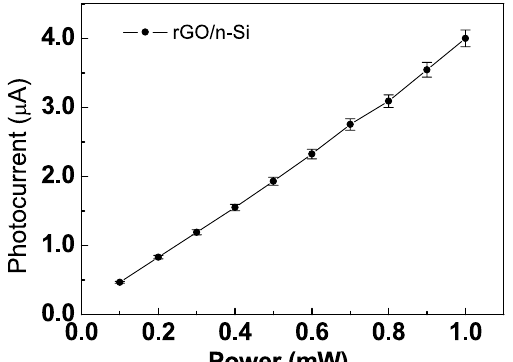
Figure 7. rGO/n-Si photocurrent at bias voltage of 25 V as a function of laser power.